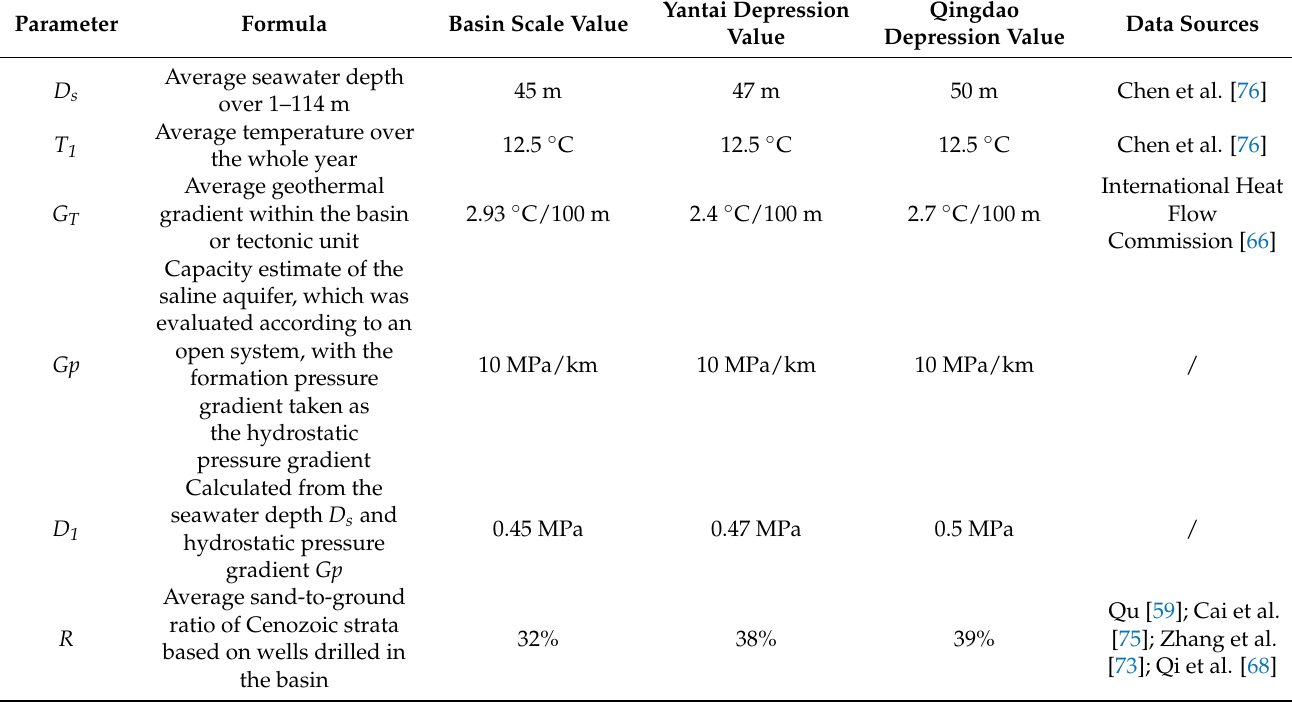
Table 1. Formulas and data sources of the calculation parameters used in this study.